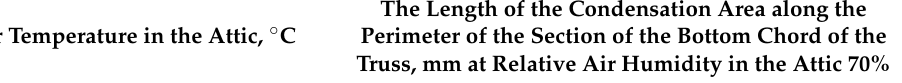
Table 3. The length of the condensation area along the perimeter of the section of the bottom chord of the truss, depending on the temperature and relative humidity of the air in the attic (calculation scheme with a gusset plate: the gaps between the angles and precast reinforced concrete elements are not filled with thermal insulation).